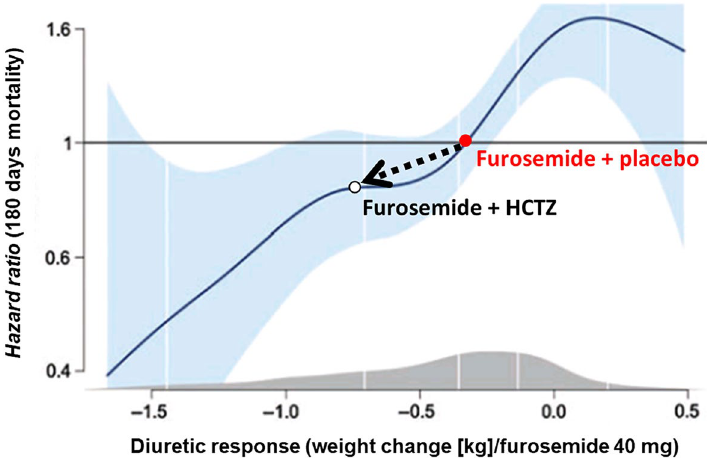
Figure 6. Effect of adding Hydrochlorothiazide (in our trial) plotted over Valente et al. data estimation of mortality based on diuretic response. Adapted from Valente et al. 18 , which suggested lower mortality with greater diuretic